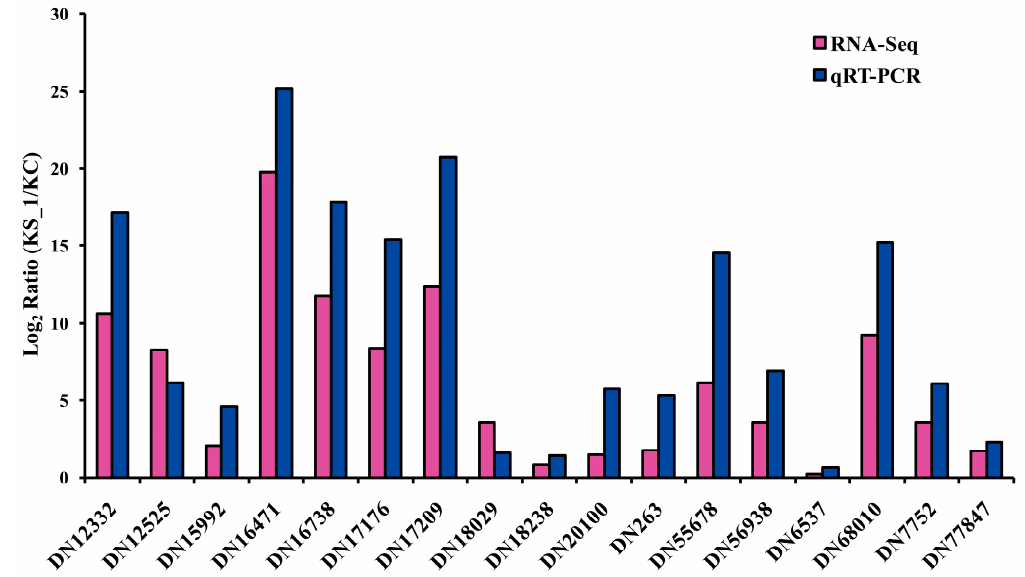
Figure 6. Validation of the expression of differentially expressed genes (DEGs) in F. proliferatum by Quantitative real-time PCR (qRT-PCR).